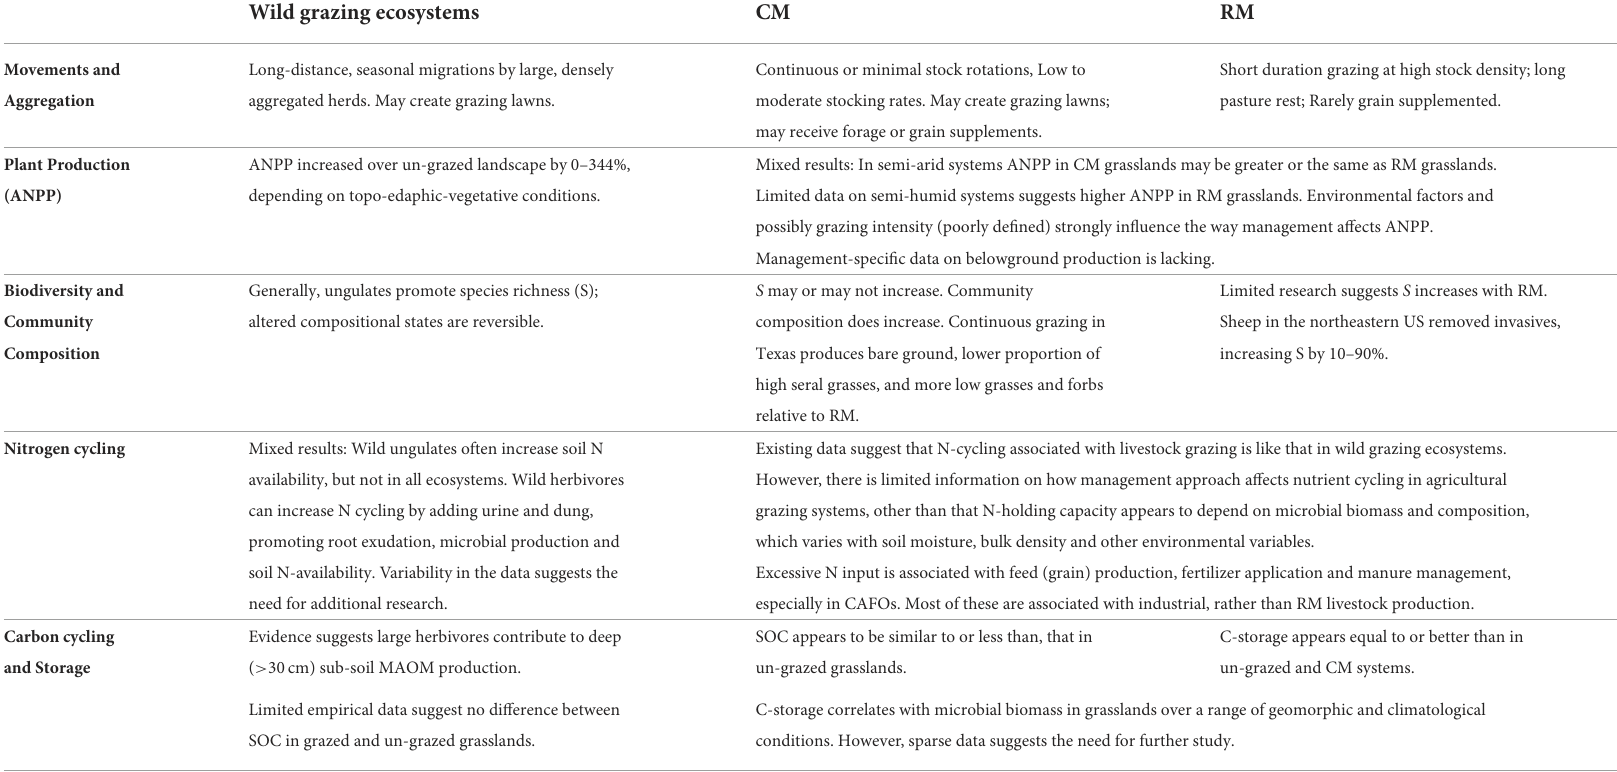
TABLE 3 Summary of key findings based on studies for which data allowed comparison of wild, conventionally managed (CM) and regeneratively managed (RM) grazing